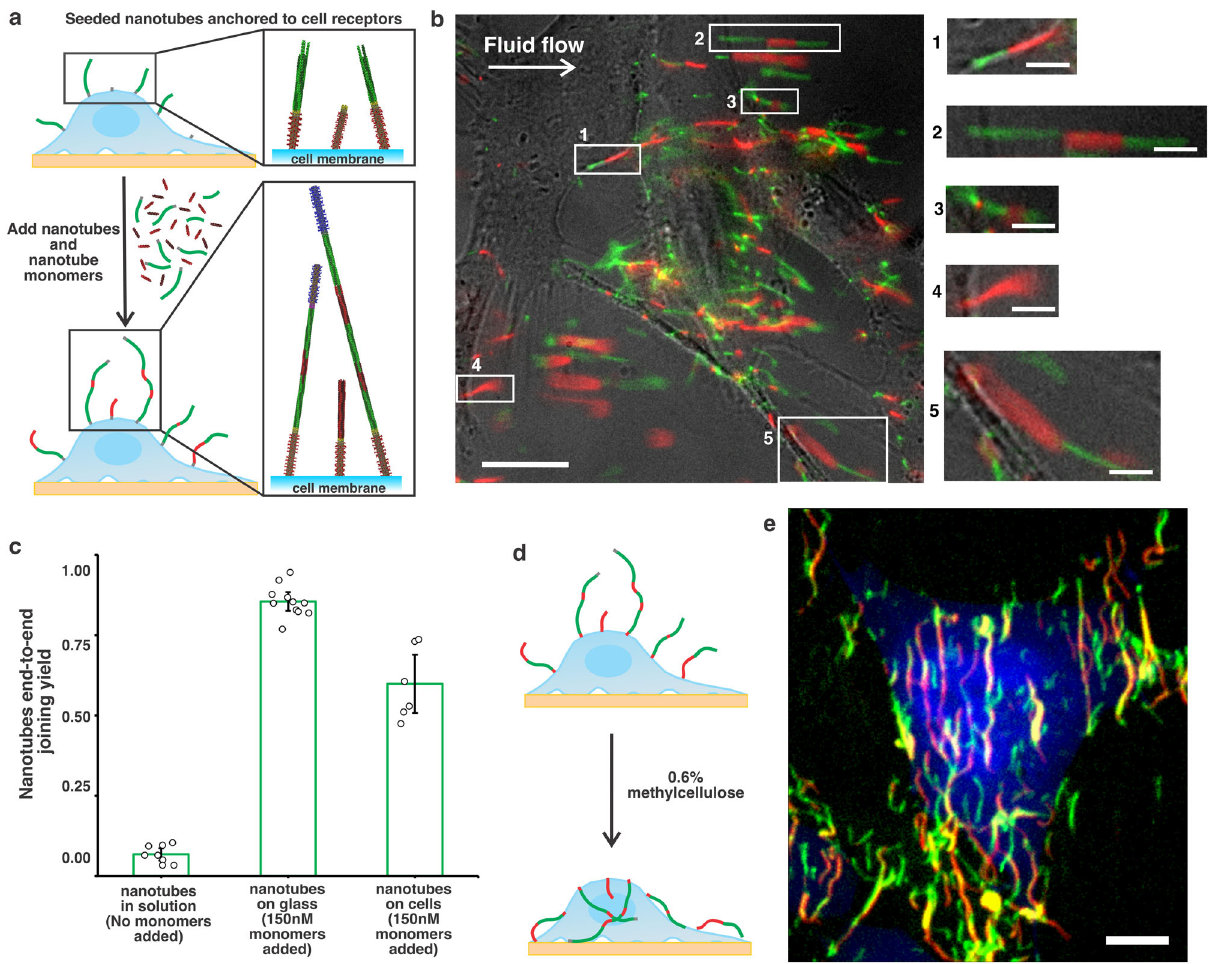
Fig. 5 Nanotube growth on the surfaces of living cells. a Schematic of nanotube growth via end-to-end joining and monomer addition. Seeds on anchored and capped nanotubes were unlabeled. Nanotubes were labeled with Cy3 (green), monomers with atto647 (red). b Two-color fl uorescence micrograph of joined nanotubes anchored to live HeLa cells. Gentle fl uid fl ow (shear stress 0.32 dyn/cm 2 ) was applied to stretch the nanotubes for better characterization (Supplementary Note S46). Scale bar: 20 μ m. Zoom-in images of end-to-end joined nanotube structures on the cell surface. Scale bar: 5 μ m. This experiment was repeated independently more than three times with similar results. c Nanotube end-to-end joining yield quanti fi cation: 6nt seeded nanotubes incubated with capped seeded nanotubes in solution at 37 °C for 3.5 h without additional monomers (Supplementary Note S42 and Supplementary Fig. S26, N = 477 nanotubes at n = 8 random locations was analyzed), 4PEG seeded nanotubes anchored on glass surface incubated with capped nanotubes and additional 150 nM monomers added at 20 °C for 3.5 h (Supplementary Note S45 and Supplementary Fig. S29, N = 803 nanotubes at n = 11 random locations was analyzed), 4PEG seeded nanotubes anchored on cell membrane incubated with capped nanotubes and additional 150 nM monomers at 20 °C for 4 h (Supplementary Note S46, N = 206 nanotubes at n = 6 random locations was analyzed). Error bars here are 95% con fi dence intervals. d and e Schematic ( d ) and 3D projection images ( e ) of joined nanotubes (green and red) on a live HeLa cell after 0.6% methylcellulose (IMDM) was added (Supplementary Note S48). Cells were transfected with GFP (blue) to reveal cell shape and extent. Scale bar: 10 μ m. This experiment was repeated independently more than three times with similar